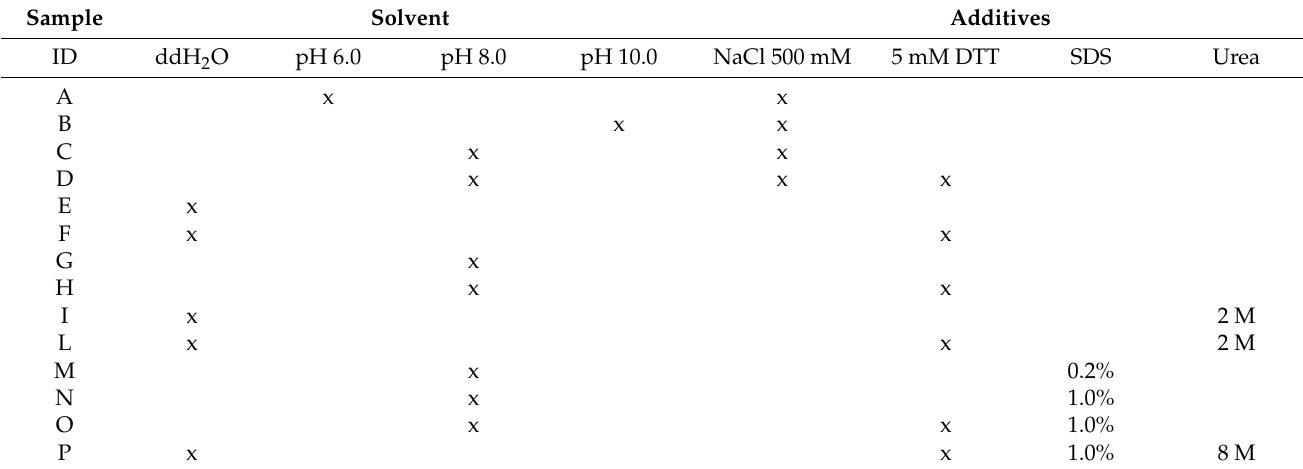
Table 1. Extraction conditions (A to P) of proteins from lyophilized okara.